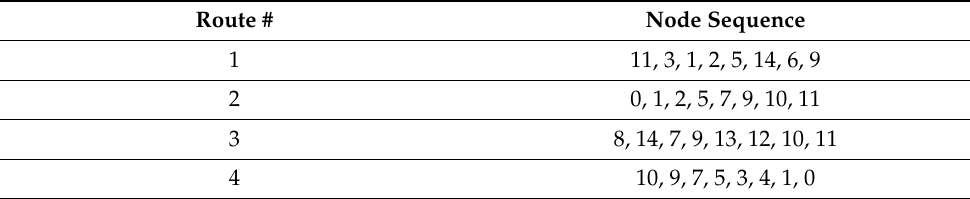
Figure 4. Best network with 4 routes. Table 2. Best Route Set for 4-Route Case.